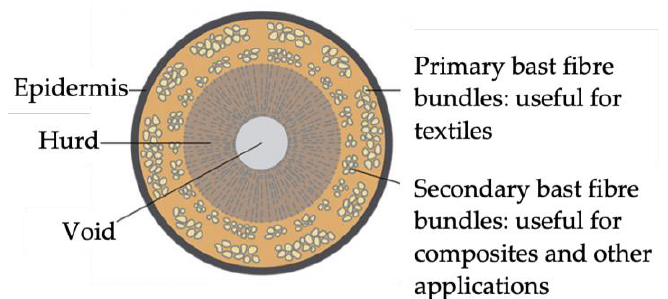
Figure 1. Schematic depiction of hemp stalk cross-section (adapted from: [23]). Flax shive and hemp hurd were characterised and used by Sam-Brew and Smith [24] to produce 3-layer lightweight particleboard (500 – 620 kg/m 3 ) with 2.5 % and 5% poly- meric diphenyl methane diisocyanate (pMDI) adhesive, respectively. The authors found lower bulk densities and higher aspect ratios of both materials compared with commercial wood (spruce, fir and pine). Longer and narrower flax and hemp particles resulted in 60% higher modulus of elasticity (MOE) and bending strength (MOR) results. All panels with 2.5% pMDI exceeded the minimum IB requirement of 0.45 MPa for medium density PB stipulated by the American National Standards Institute (ANSI). Using hemp hurd re- sulted in significantly higher IB results compared to the flax and wood equivalents. The use of 5% pMDI generated the highest IB values in the wood PB. The authors concluded that shorter and finer wood particles created better packing efficiency (particle contact) and consequently greater IB strength. Balducci et al. [8] examined agricultural plants, i.e., hemp ( Cannabis sativa L . ), sunflower ( Helianthus annuus L.), topinambur ( Helianthus tu- berosus L.), maize ( Zea mays L.), and miscanthus ( Miscanthus sinensis 'Giganteus') as possi- ble constituents for lightweight PB (400 kg/m 3 ) intended for the furniture industry. Details of pressing parameters, initial moisture content (MC) of the raw material and particle ge- ometries were not reported. However, the authors referred to the ‘chip - like’ and ‘cubical’ hemp particle geometry and commented on its low-density. Most single-layer PB failed to meet the EN 312 requirements for type P2 PB (0.35 MPa) except for topinambur (0.36 MPa). Schöpper et al. [7] manufactured 3-layer PB with densities of 450 kg/m 3 and 550 kg/m 3 from hemp particles (hurd and leaves) and 10% UF resin. The boards comprised fine particles in the surface layers (20% of total particle amount) and coarse particles in the core layer (60% of total particle amount). However, the particle sizes were not speci- fied. Integrated woven hemp fabrics increased IB strength and allowed meeting EN re- quirements for both panel densities. The authors acknowledged the essential contribution of particle configuration and suggested optimising the particle sizing and milling process for improved mechanical properties of hemp PB with reduced density. The effect of ho- mogeneity and particle geometries on the properties of kenaf ( Hibiscus cannabinus L.) and rubberwood ( Hevea brasiliensis Müll.Arg) PB was assessed by Juliana et al. [25]. Particles were blended with 10% UF resin targeting a density of 700 kg/m 3 . A particle geometry analysis was performed on two-particle size categories (0.5 – 1 mm and 1 – 2 mm), each with 100 particles to identify aspect ratios and particle shape classes. The authors concluded that the greater density of rubberwood and slender particle shapes led to superior IB re- sults. Low IB results, they suggested, were caused by greater hydrophilicity of kenaf core (uneven resin distribution) and poor resin penetration of kenaf bast particles (waxy cuticle layer). Li et al. [26] examined the influence of particle size categories and adhesive type on the properties of PB from rice straw ( Oryza sativa L. ) . Panels targeting 700 kg/m 3 were prepared from different particle sizes (sieve openings of 1.59, 3.18, 6.35, 12.70, 19.05 and 25.40 mm) with UF and pMDI adhesive, respectively. The authors observed significantly higher results in pMDI PB and an IB increase with decreasing particles size previously observed by Pizzi [27]. They suggested that unsplit rice particles found in smaller particle sizes categories enhanced inter-particle bonding (lack of inorganic substances).